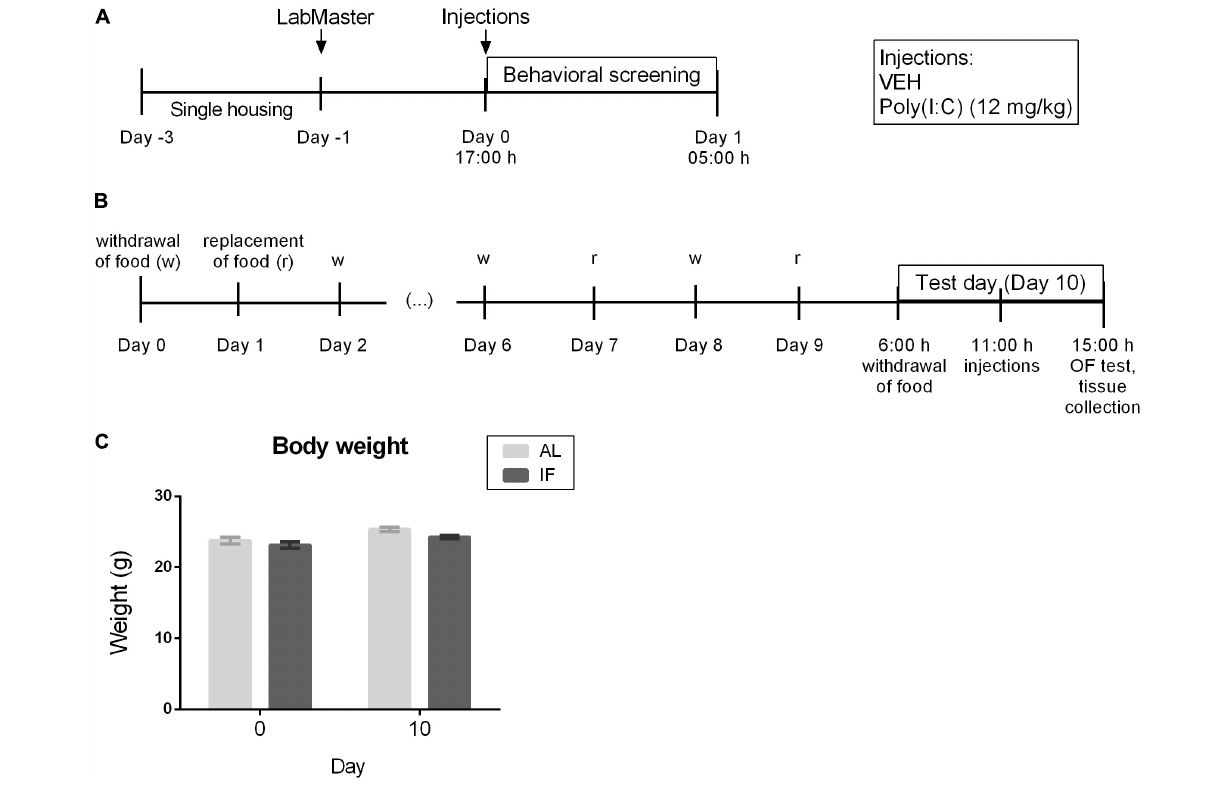
FIGURE 1 | Experimental time lines and body weight recordings. (A) Time course of the effects of i.p. injection of vehicle or Poly(I:C) (12 mg/kg) on locomotor and exploratory behavior as well as food and water intake assessed in the LabMaster system ( n = 6). (B) Effect of intermittent fasting (IF) for 9 days on the sickness behavior in the open field (OF) evoked by i.p. injection of vehicle or Poly(I:C) (12 mg/kg) on day 10 ( n = 7–9). (C) Body weight of mice at days 0 and 10 ( n = 6). RM two-way ANOVA results: F (1, 10) = 0.7946, p = 0.3937 for interaction of time/feeding in body weight; F (1, 10) = 25.84, p ≤ 0.001 for main effect of time on body weight; F (1, 10) = 3.199, p = 0.1040 for main effect of feeding regimen on body weight. Abbreviations: AL, ad libitum